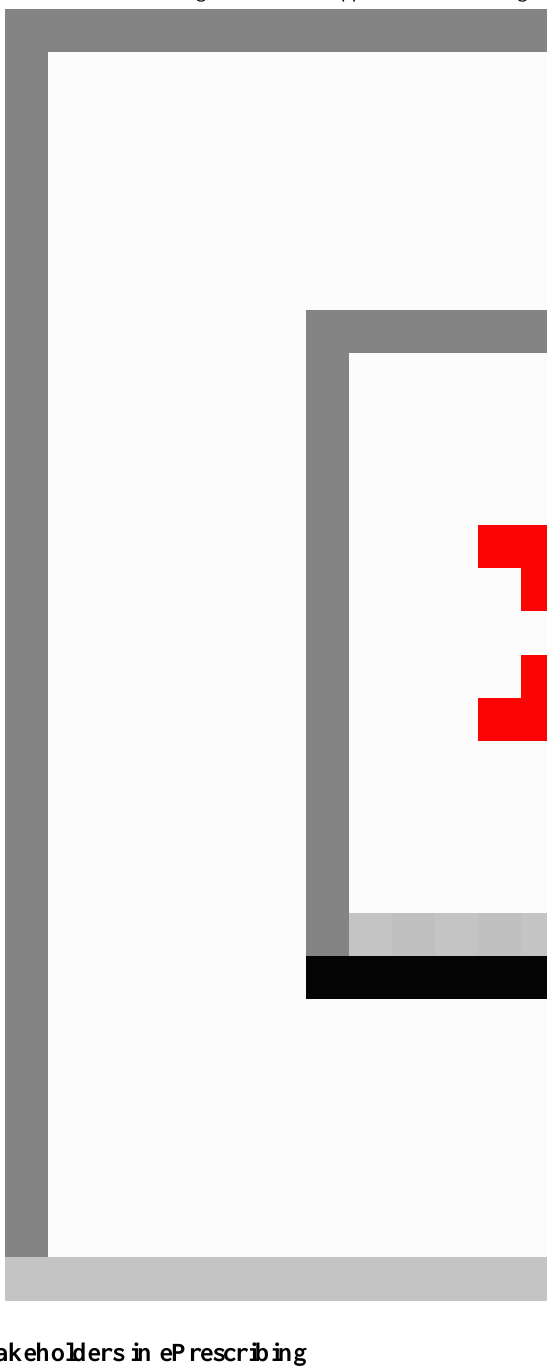
Figure 1. The Generic Regulation Model applied to ePrescribing